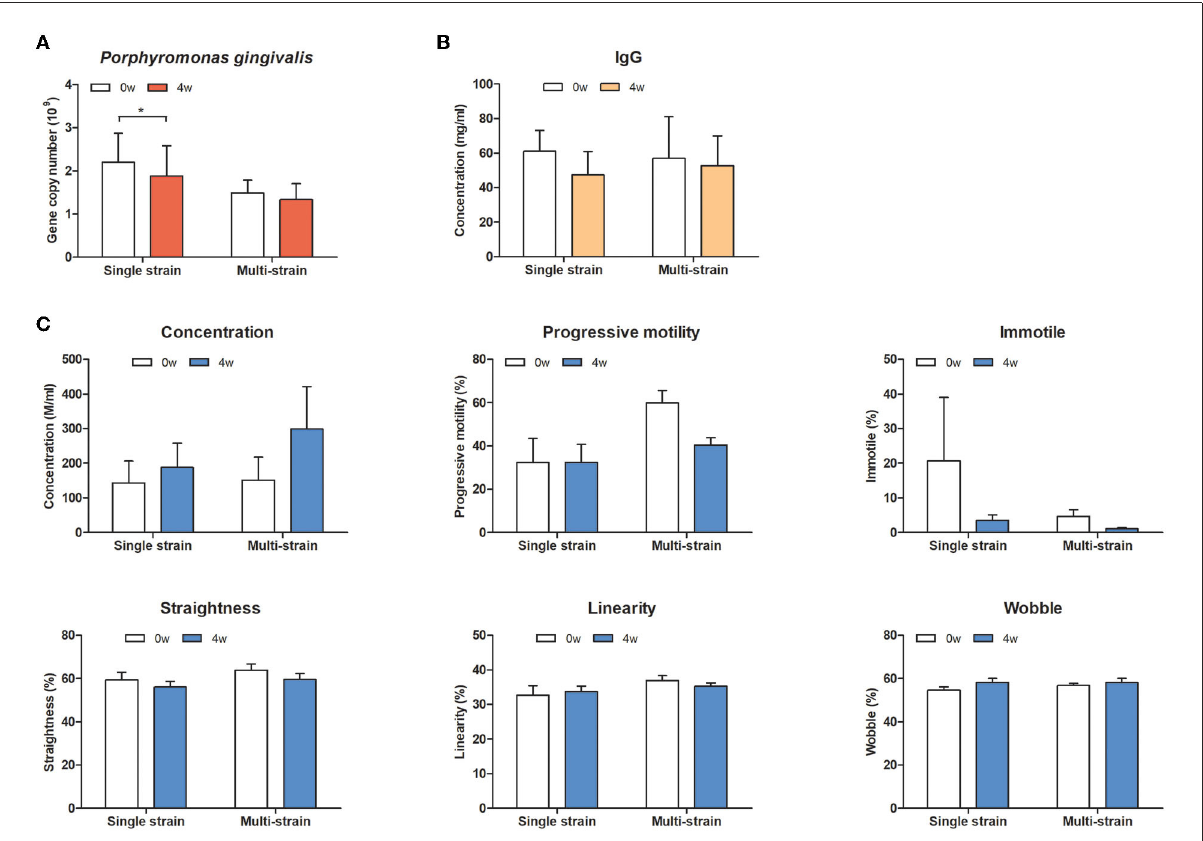
FIGURE3 Effect of oral administration of a single strain or multiple strains in dogs. (A) The counts of P. gingivalis , (B) serum IgG level, and (C) sperm quality-relative parameters. Single strain; MJC175, Multiple strains; MJC175, MJC178, and